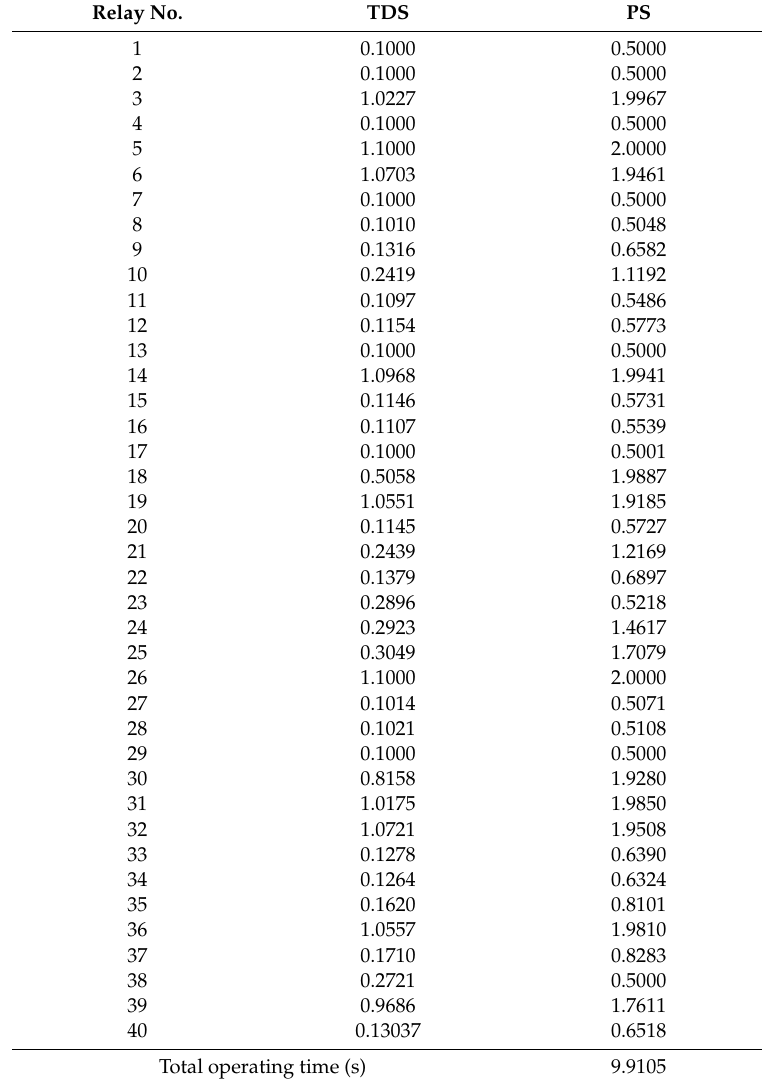
Table 21. Optimal TDS for the IEEE 14-bus